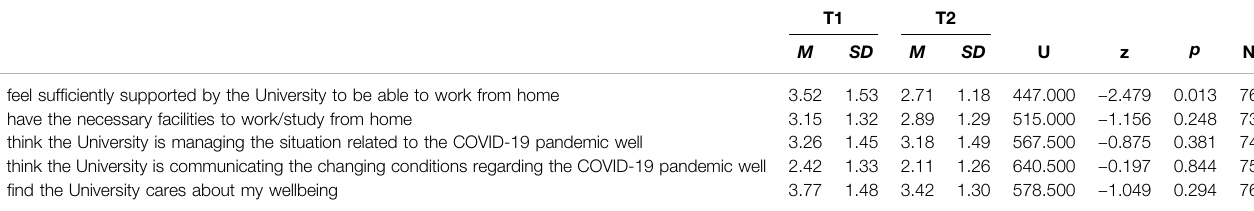
TABLE 2 | Staff perceptions of support, over time.